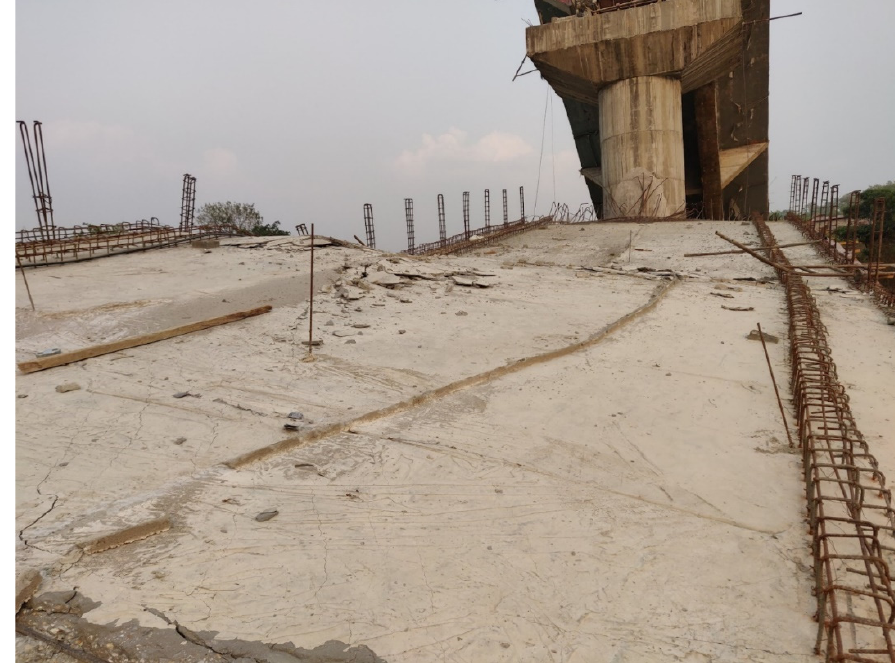
Infrastructures 2022 , 7 , x FOR PEER REVIEW Figure 10. Cracks observed along the slab surface of Span-2. Figure 10. Cracks observed along the slab surface of Span-2.